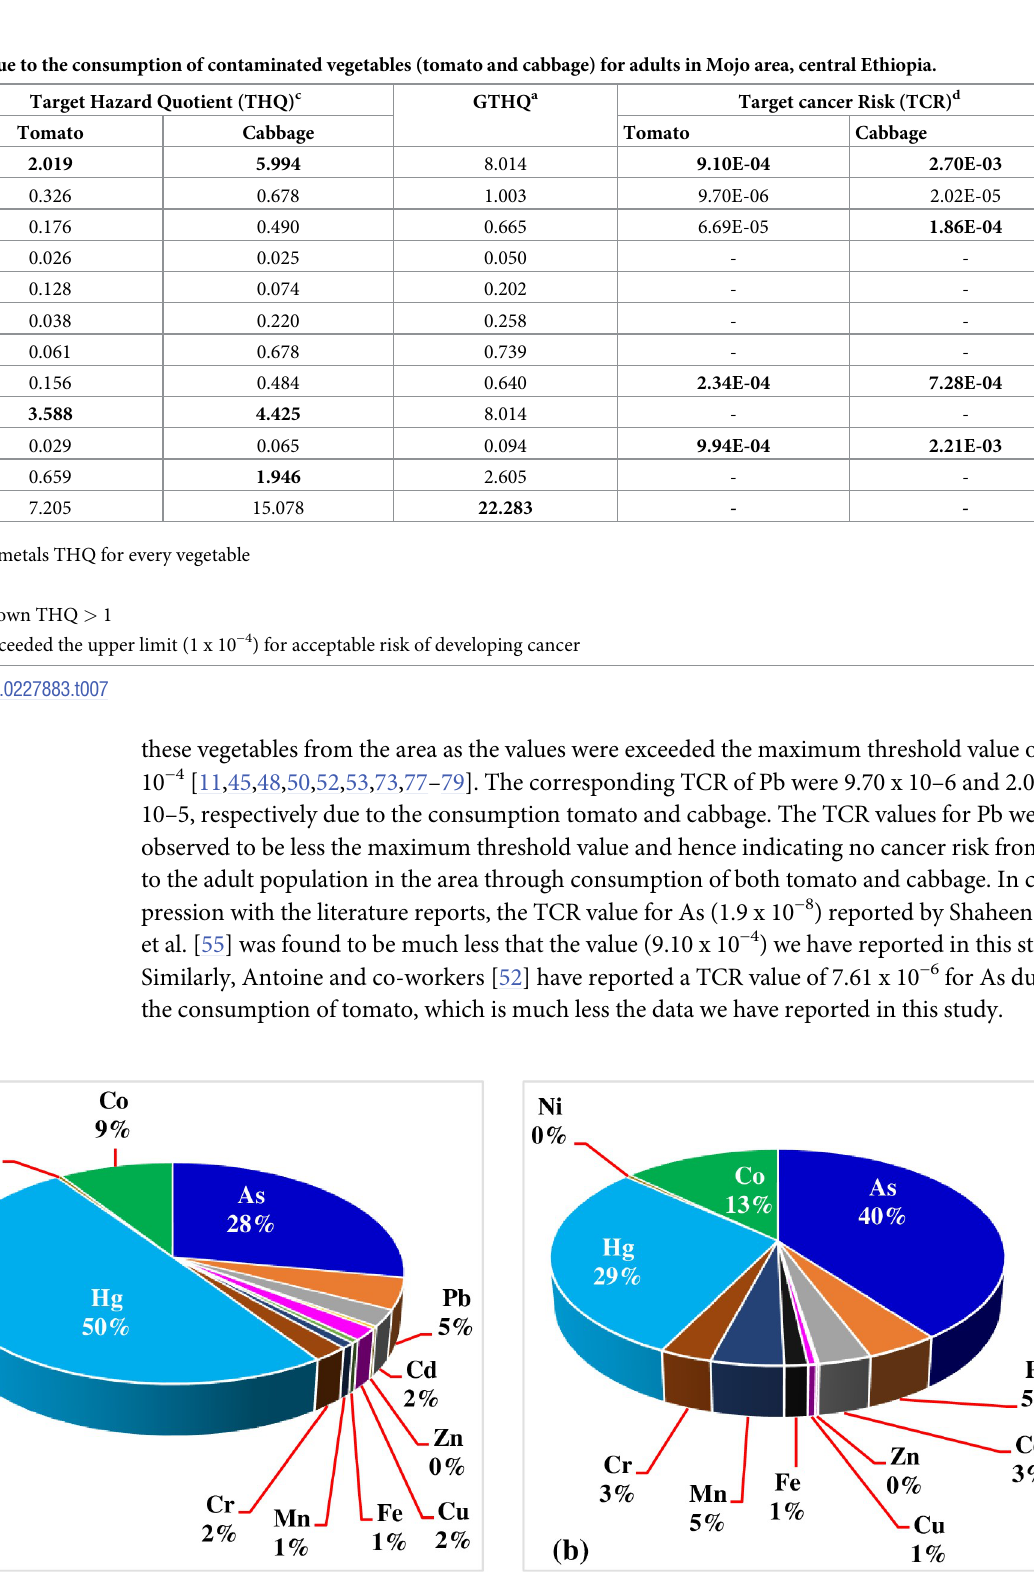
Fig 2. The average contribution of heavy metals to the HI due to the consumption of tomato (a) and cabbage (b).